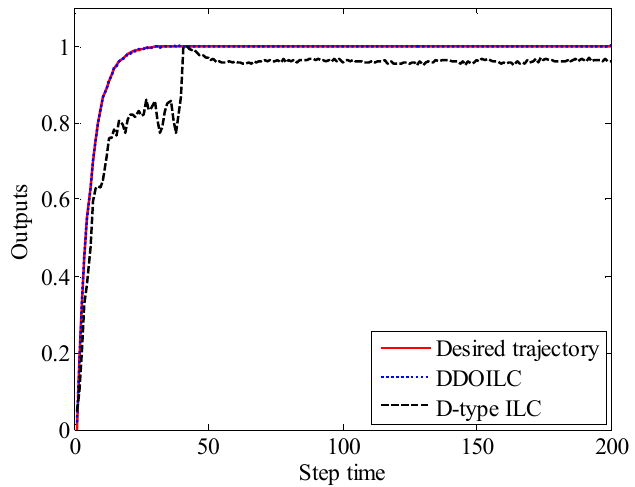
Figure 8. Outputs of the DDOILC and D-type ILC at the 4-th batch.